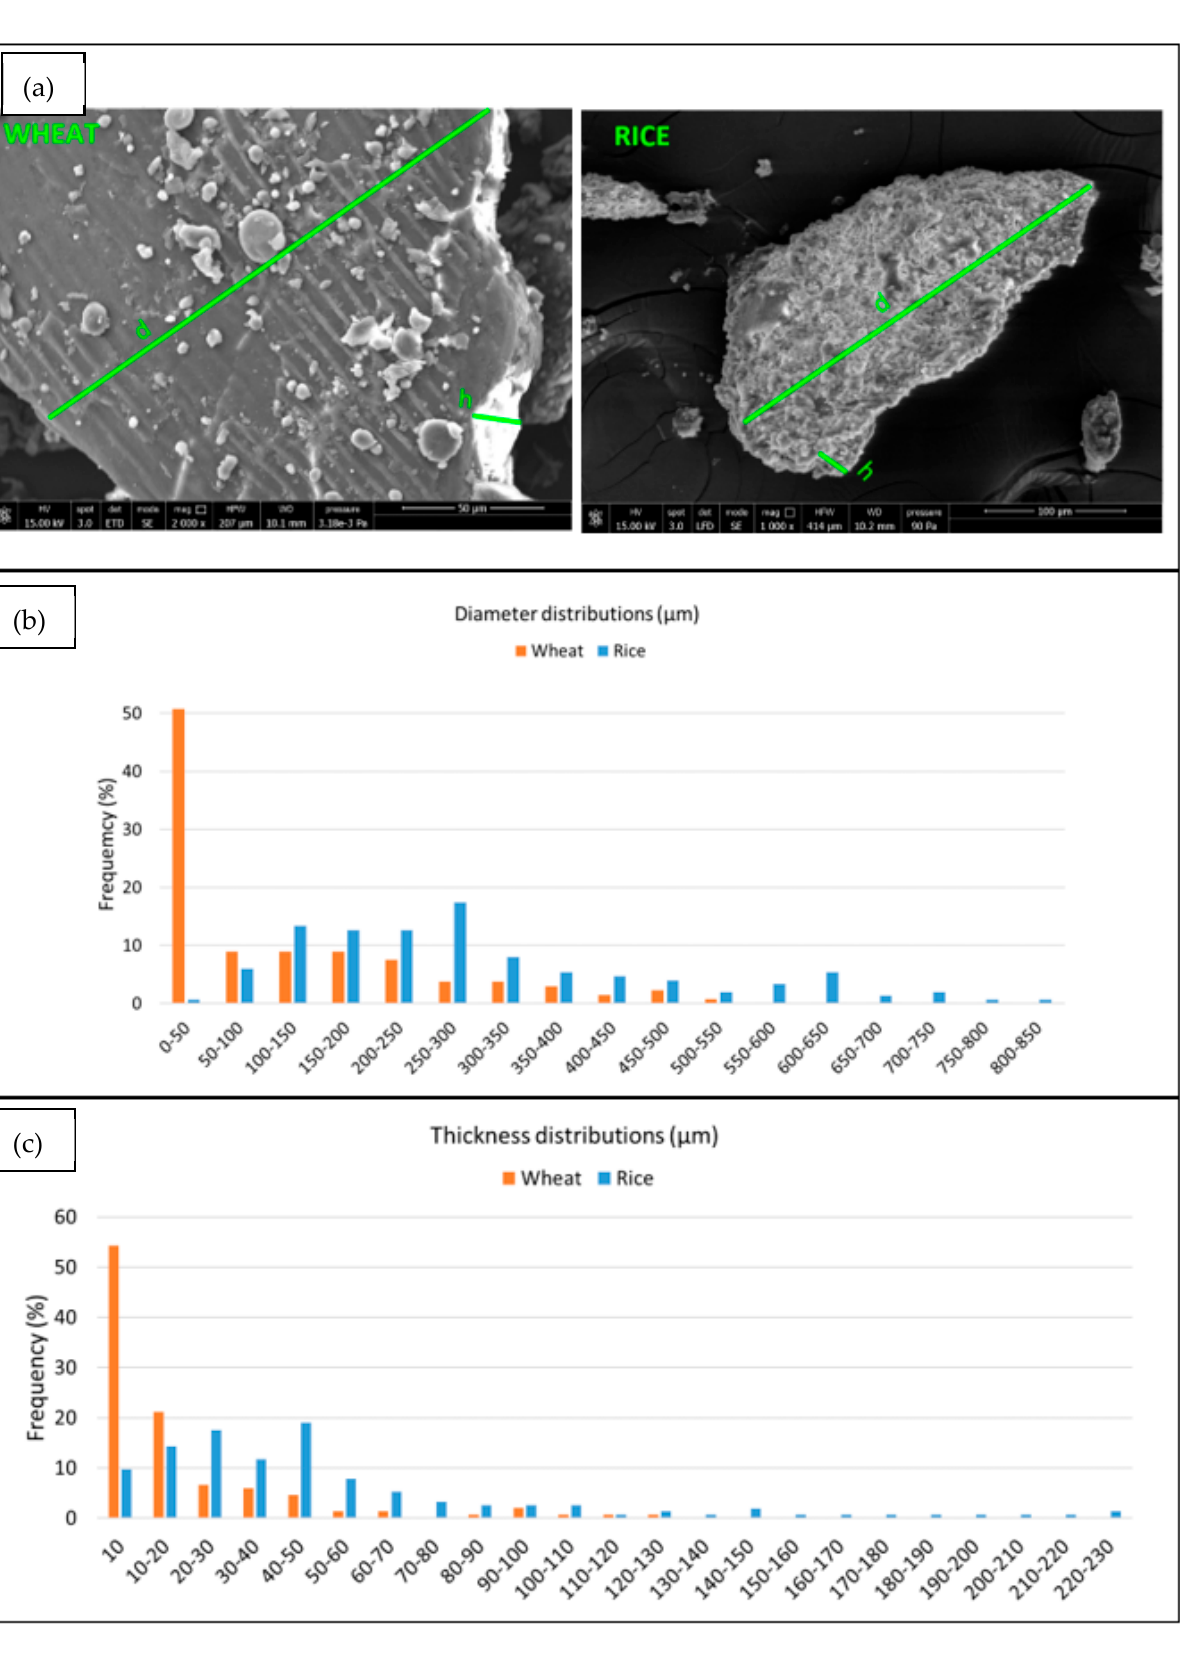
Figure 3. ( a ) 2000× magnification of Wheat Bran and Rice Bran ( b ) diameter distribution ( c ) thickness distribution.